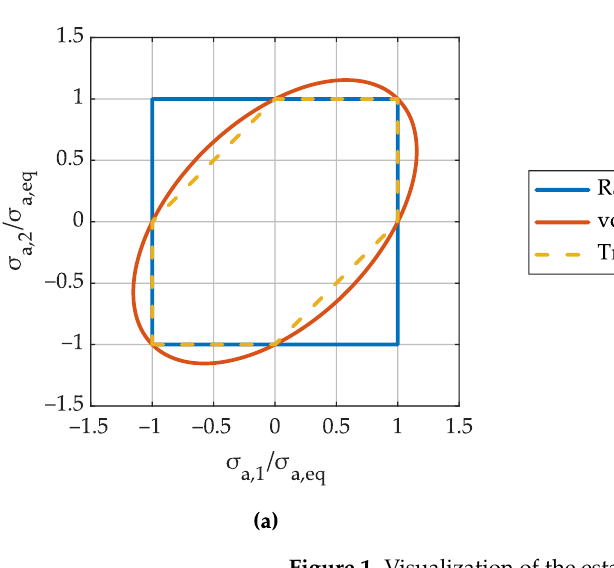
Figure 1. Visualization of the established strength hypotheses according to Rankine, von Mises, and Tresca for proportional loading as ( a ) principal stress diagram and ( b ) for different combinations of permutable normal and shear stress (both for plane stress states, σ 3 = 0 ).